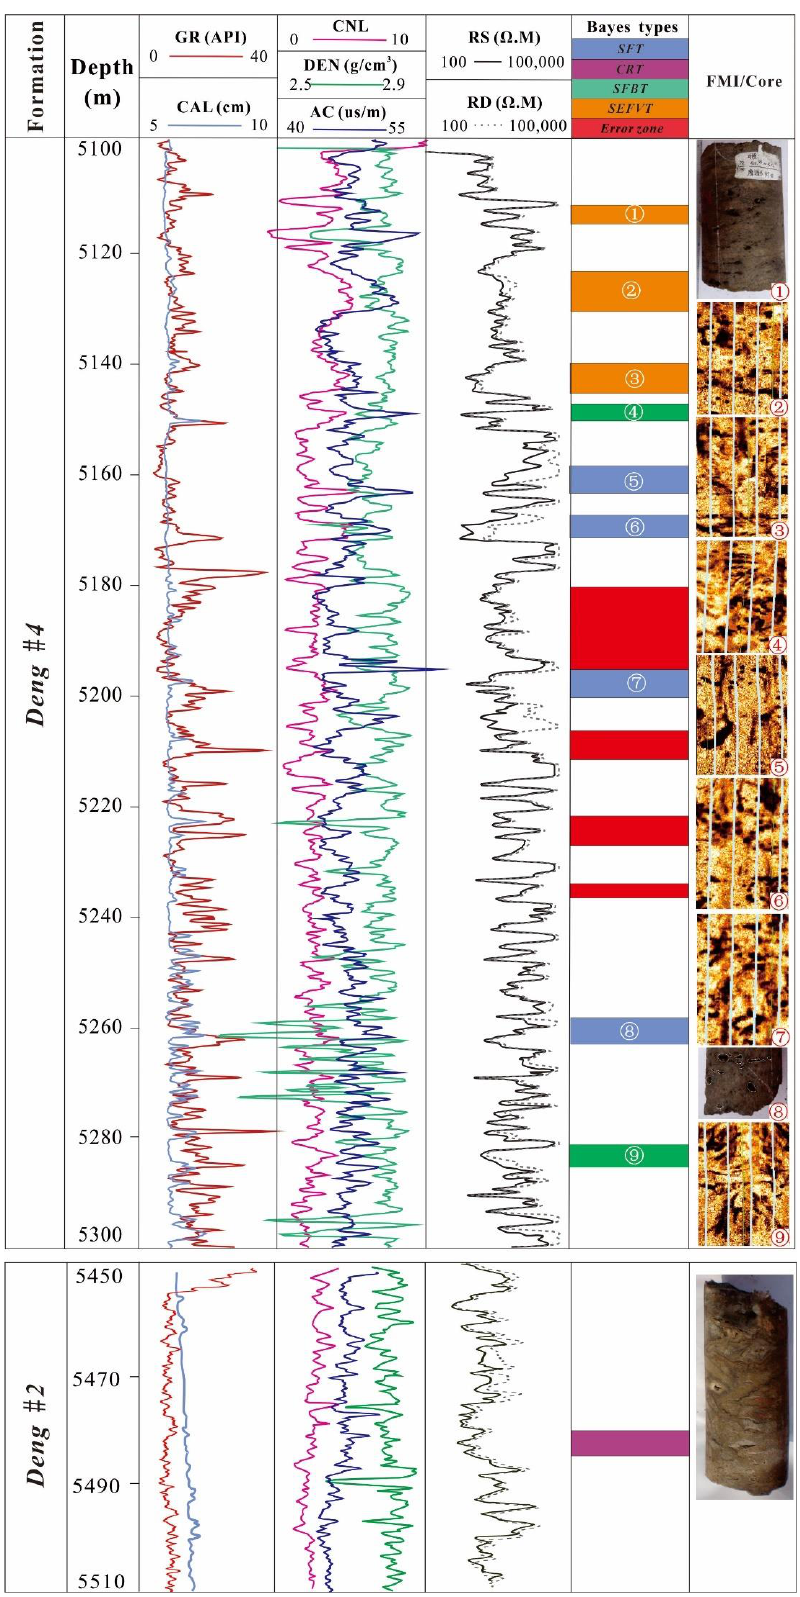
Figure 10. Comparison of identification and FMI/core results of two intervals of the Deng #4 (depth of 5100 and 5300 m from Well #3) and Deng #2 (depth of 5450 and 5510 m from Well